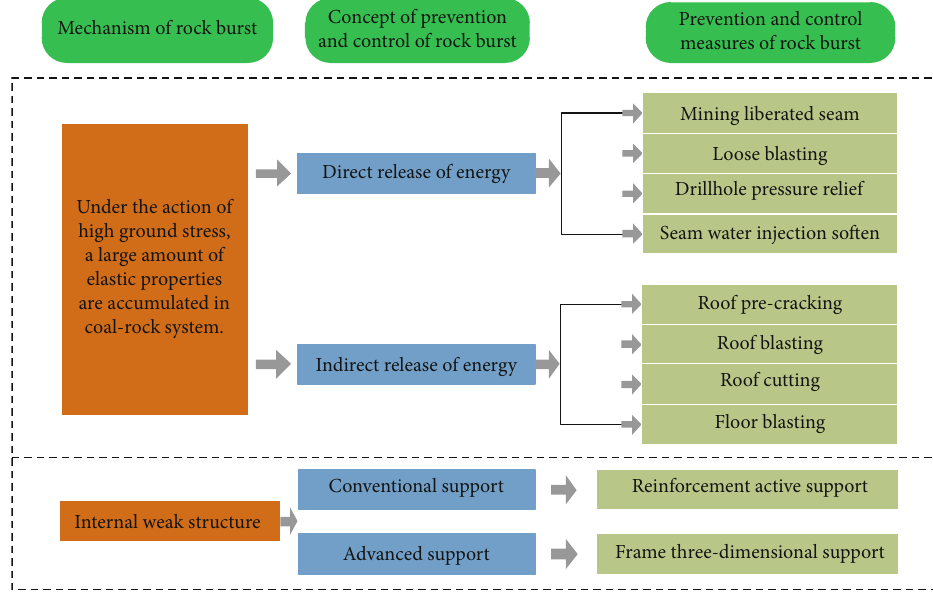
Figure 15: Flow diagram of rock burst energy release. Table 5: Rock layer parameters of coal seam roof and fl